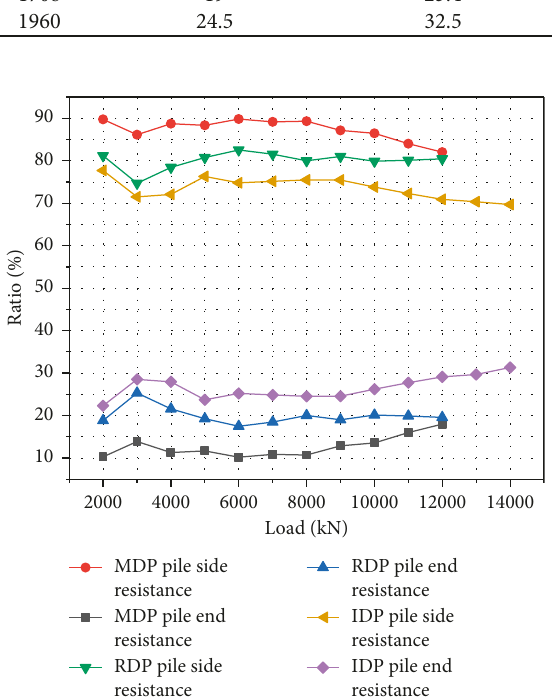
Figure 19: The ratios of every resistance to the total